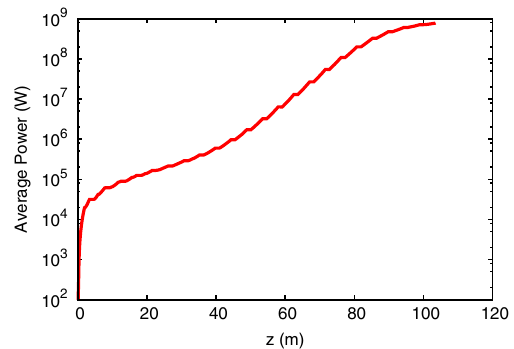
should decrease from 5.48 to 2.44. max